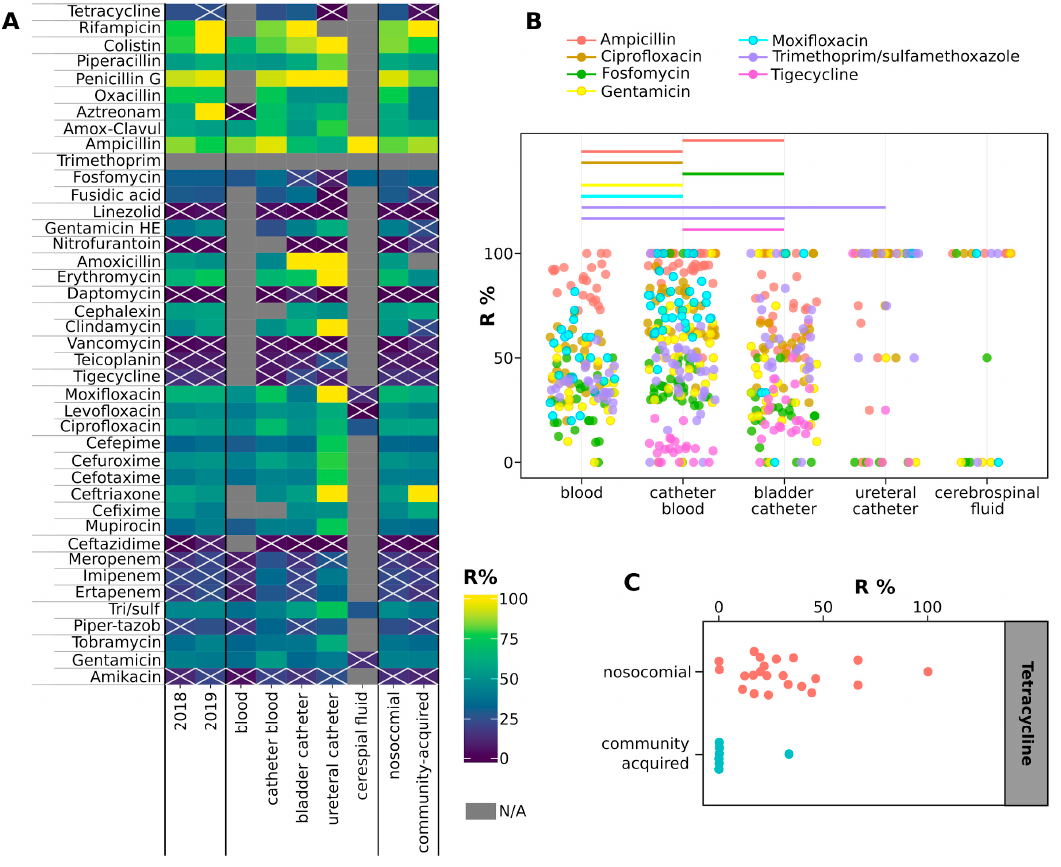
Figure 6. ( A ) Heatmap showing the percentages of resistant strains grouped according to the classification indicated in columns. The color of each cell shows the percentage of strains resistant to the antibiotic listed in rows, with N / A indicating that strains of the corresponding group were not tested with the antibiotic indicated in the row. Crossed cells indicate groups of isolates not significantly more resistant to the antibiotic indicated in the row compared to the rest of the antibiotics (two-sided, unpaired Welch t -test fdr > 0.05, comparing the % of strains of the group resistant to the antibiotics to the % of resistances of the group of strains). ( B ) box plots showing the percentages of strains resistant to the listed antibiotics according to the isolation source. Only drugs for which significant di ff erences in resistance percentages have been observed between isolation sources are shown. Horizontal lines indicate significant di ff erences among resistance percentages to the antibiotic indicated with the color (Wilcoxon test fdr < 0.05). ( C ) box plot showing the percentages of strains resistant to the listed antibiotics according to the infection type. In panels B and C, each point represents a group of isolates (strains isolated from the same specimen, in the same year and month, and associated with the same type of infection).